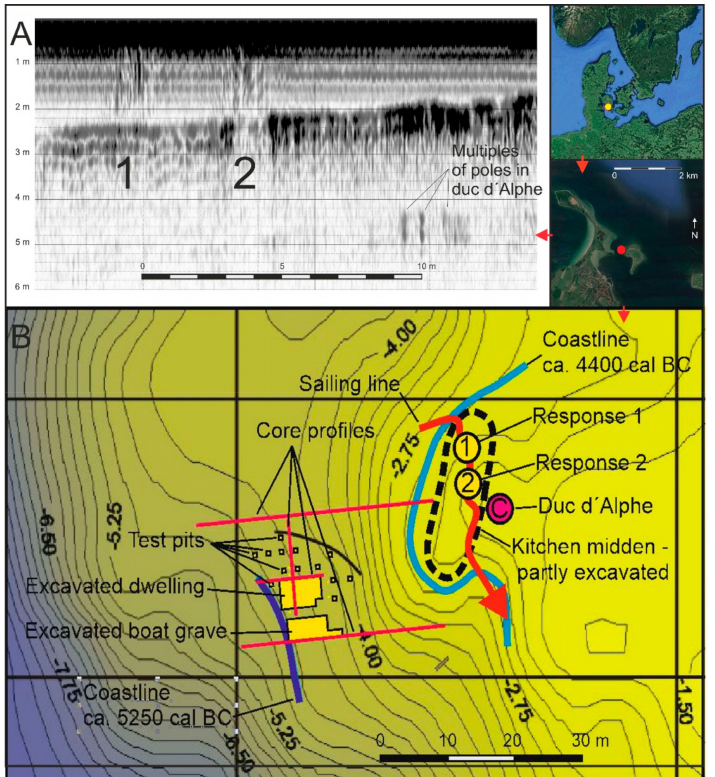
Figure 10. Recordings from 1996 of the submerged Stone Age settlement Møllegabet, Denmark, with a Datasonics Chirp II system, the predecessor of the Teledyne Chirp III. ( A ): Section cutting N-S through the kitchen midden at Møllegabet with two haystack features, 1 and 2. ( B ): A Bathymetric plan over the excavated Late Mesolithic archaeological features and the coastlines they date. The sailing line of A is shown in B as a bold, red arrow. Graphic: